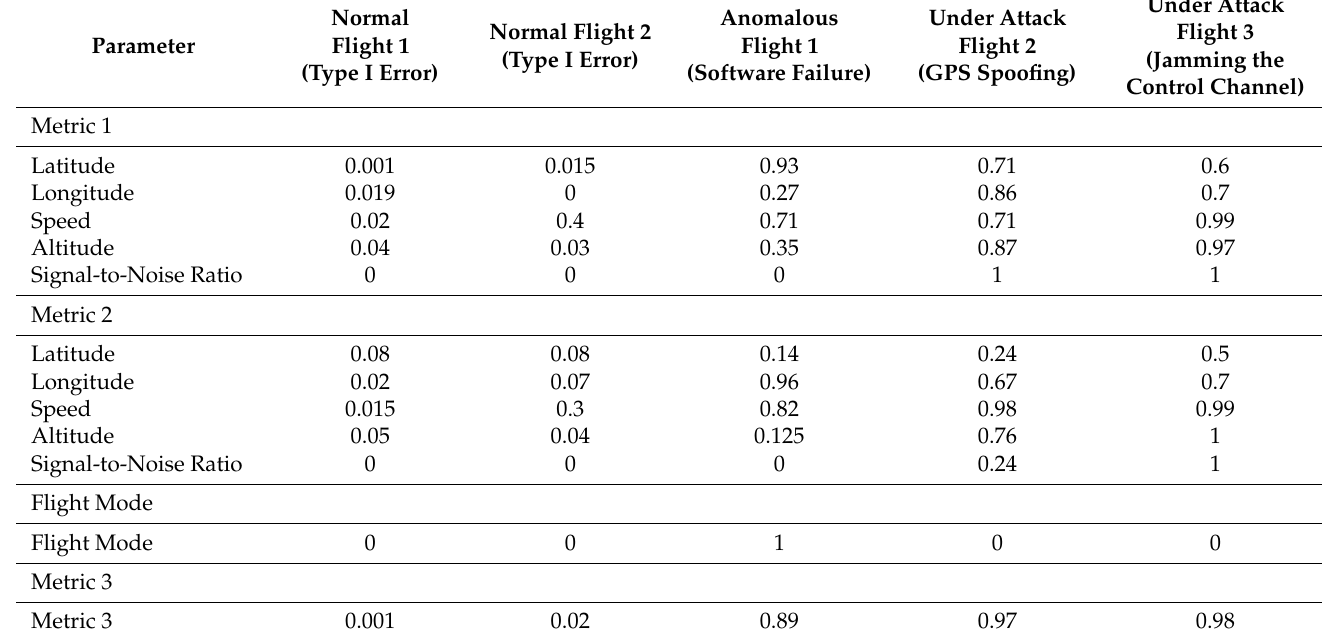
Table 4. Detection accuracy